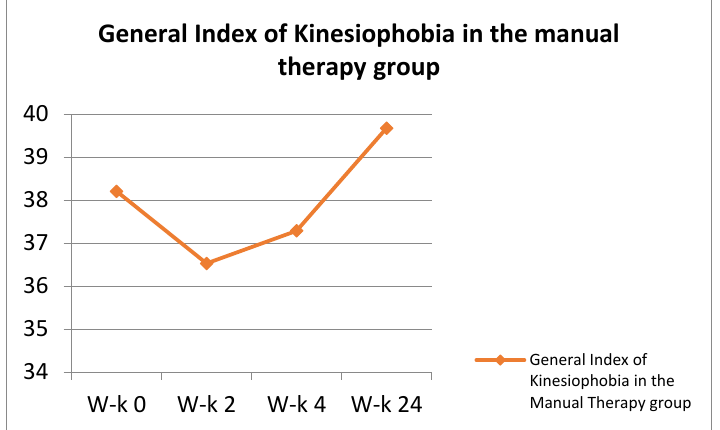
Figure 2. General Index of Kinesiophobia in the manual therapy group.